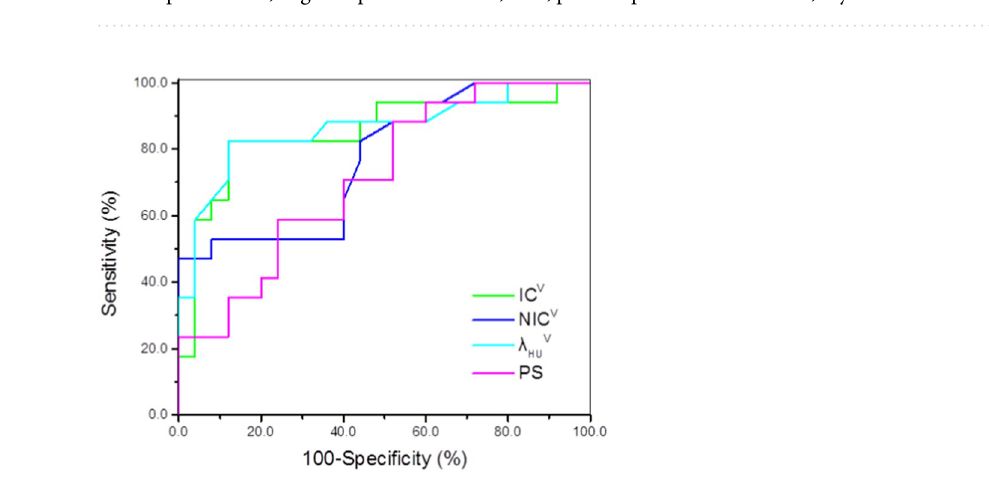
Table 6. ROC results of PS, IC v , NIC v , and λ HUv values differentiating HRT * from TC. ROC, receiver operating characteristic curve; AUC, area under the receiver operating characteristic curve. PS, permeability surface; IC, iodine concentration; NIC, normalized iodine concentration; λ HU , slope of spectral HU curve; V, the optimal venous phase. NPV, negative predictive value; PPV, positive predictive value. TC, thymic